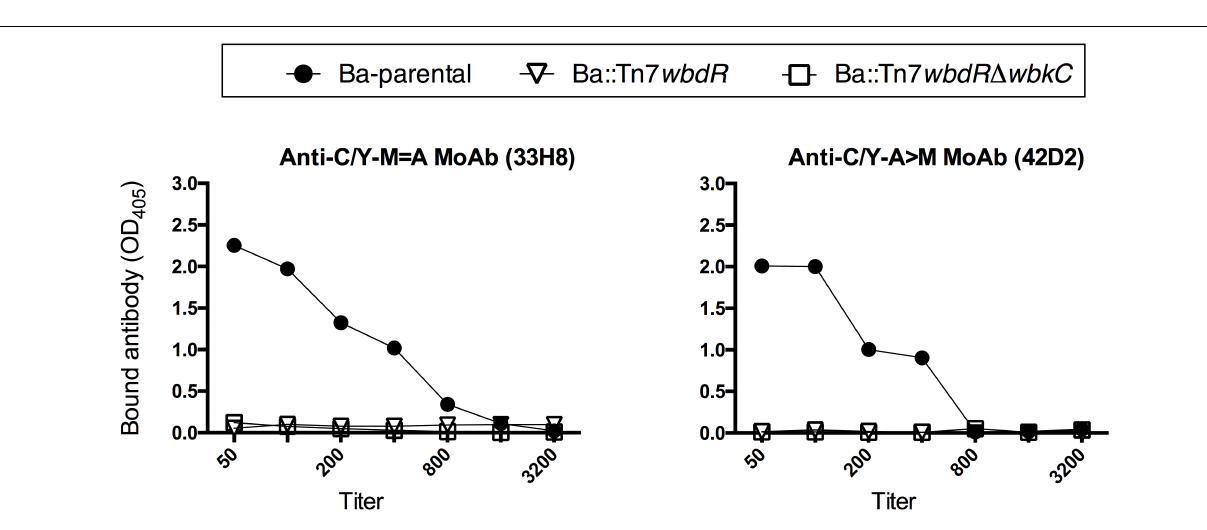
FIGURE 5 | N -acetyl-perosamine alters the epitopic structure of S-LPS. Upper panels: Reactivity with monoclonal antibodies of C/Y-A = M and C/Y-A > M specificities in an ELISA performed with the S-LPS of Ba-parental or B. abortus wbdR